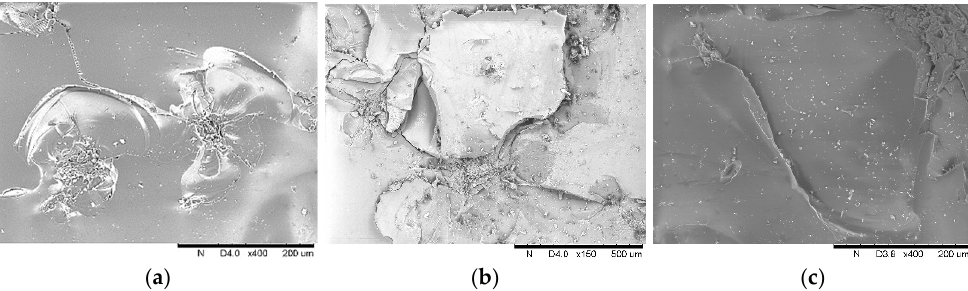
Figure 4. Damage modes of glass specimens: ( a ) cutting, Ps-10-30; ( b ) smashing, Ps-10-90; and ( c ) plastic deformation, Ps-12-30.